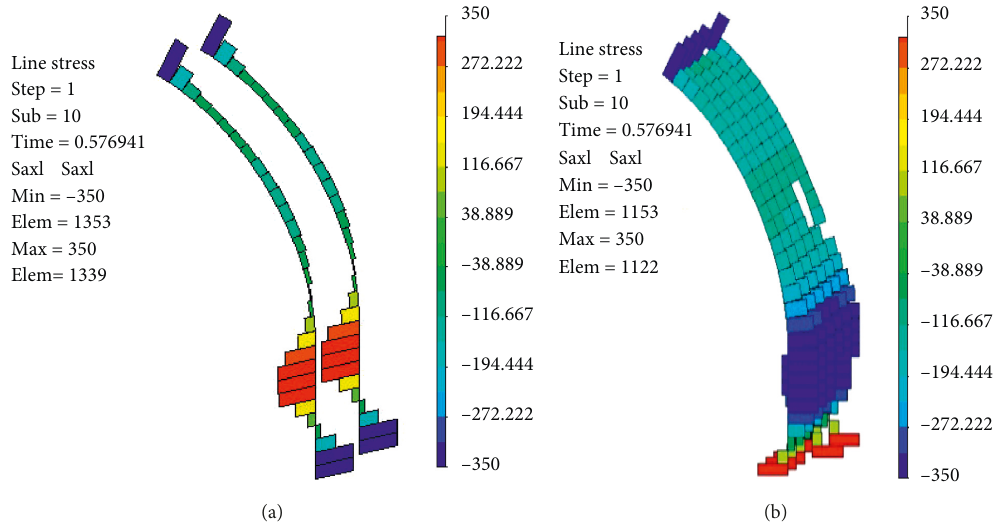
Figure 8: Stress distribution of steel bar on (a) main reinforcement and (b) surface steel bar.